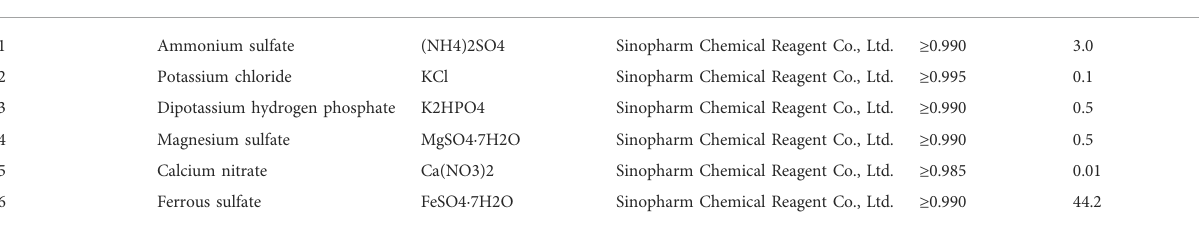
TABLE 2 Composition of 9 K